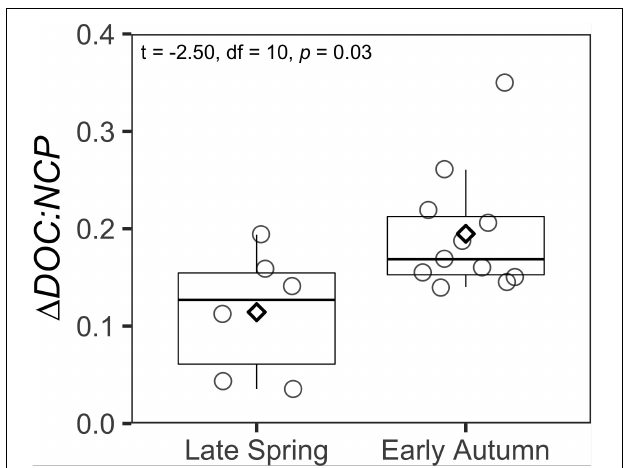
FIGURE 5 | Box and whisker plots comparing (cid:49) DOC:NCP integrated over the surface 100 m between the late spring and early autumn. Boxes represent the median and the first and third quartiles. Whiskers represent the 1.5 interquatile range. Circles indicate data points. Diamonds represent the mean of the